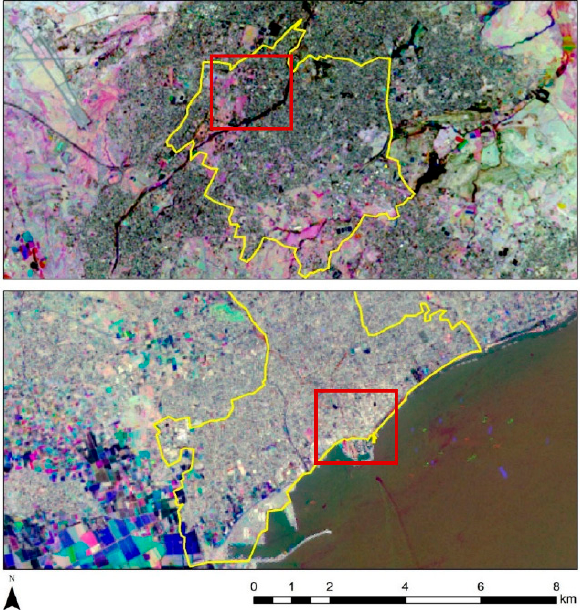
Figure 9. Pseudo-colour RGB composites from the NDBI annual maps using the reference years of 2013 (B), 2017 (G), and 2020 (R). On top is the results from the Strovolos case study and on the bottom the results from the Limassol case study.